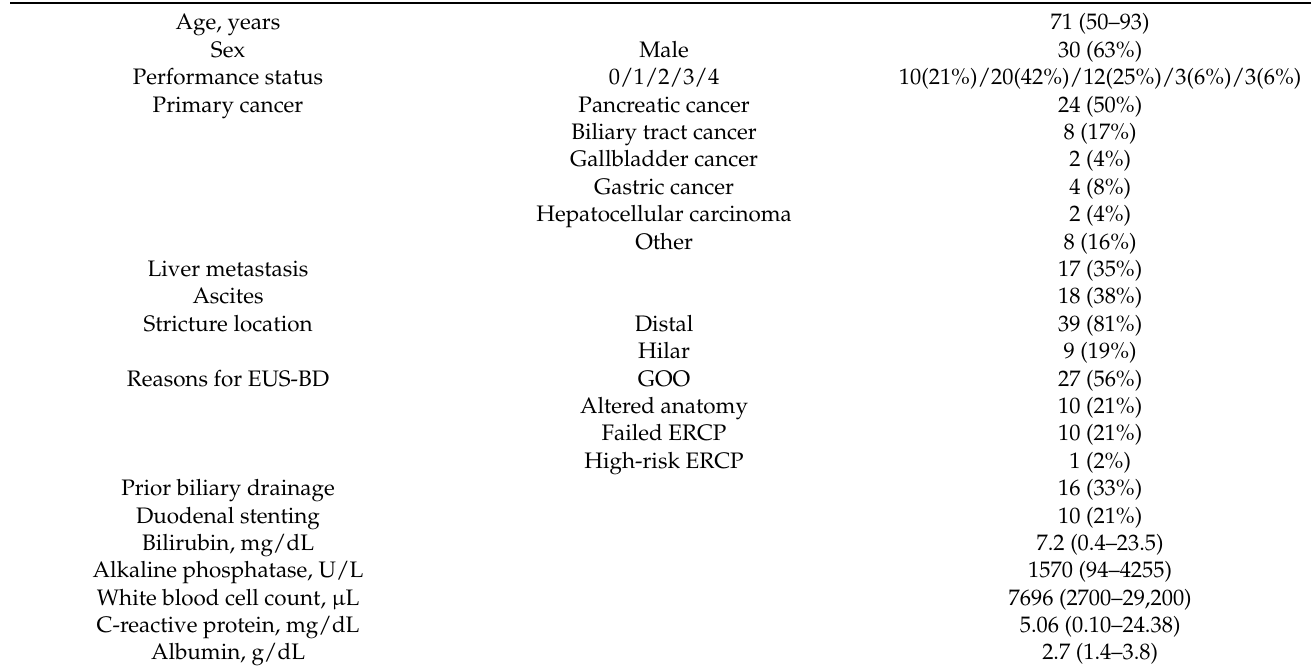
Table 1. Patient characteristics.